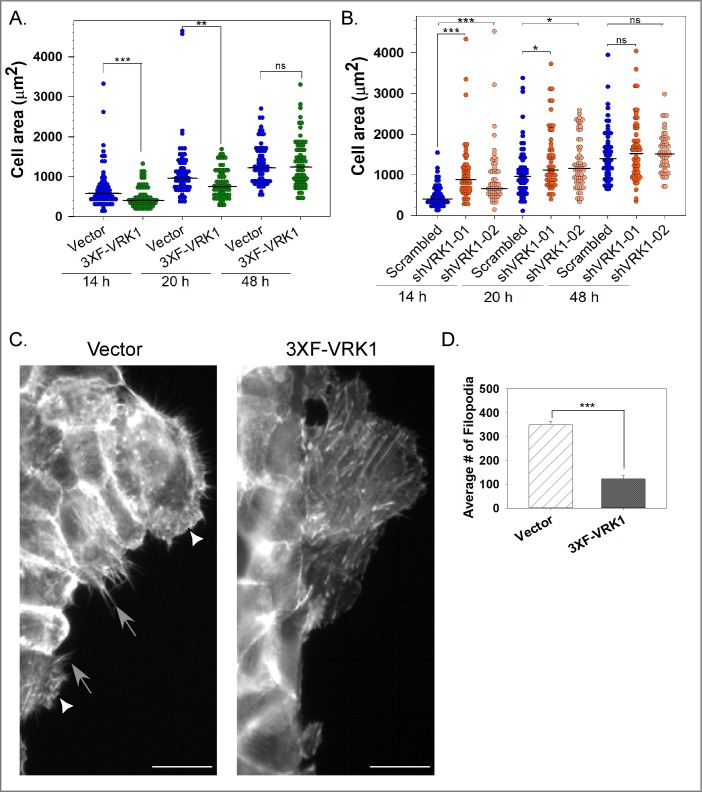
VRK1 levels modulate cell spreading and cytoskeletal rearrangement.(A) To assess the rate of cell spreading, the areas of individual vector control (blue circles) and 3XF-VRK1-overexpressing (green circles) MCF10A cells were measured at 14, 20, and 48h post seeding (n = 60 cells). (B) As for panel A, the areas of individual scrambled shRNA control (blue circle), sh-VRK1-01 (orange circle), and sh-VRK1-02 (light orange circle) MCF10a cells were measured at 14, 20, and 48h post seeding (n = 60 cells). In Figs A and B, bars indicate the median; statistical significance was determined by Mann-Whitney test. (C and D) Stable MCF0a cells co-expressing either GFP-LifeAct and vector control or GFP-LifeAct and 3XF-VRK1, were wounded and monitored for the rearrangement of the cytoskeleton using time-lapse imaging. Representative images of the cytoskeletal organization of cells along the leading edge are shown in C. White triangles indicate lamellipodia and gray arrows indicate filopodia. Scale bar = 100 μm. Quantification of the average number of filopodia per 40X magnification field is shown in D. (Mean and standard error shown; ***p<0.001) (n = 6 images).